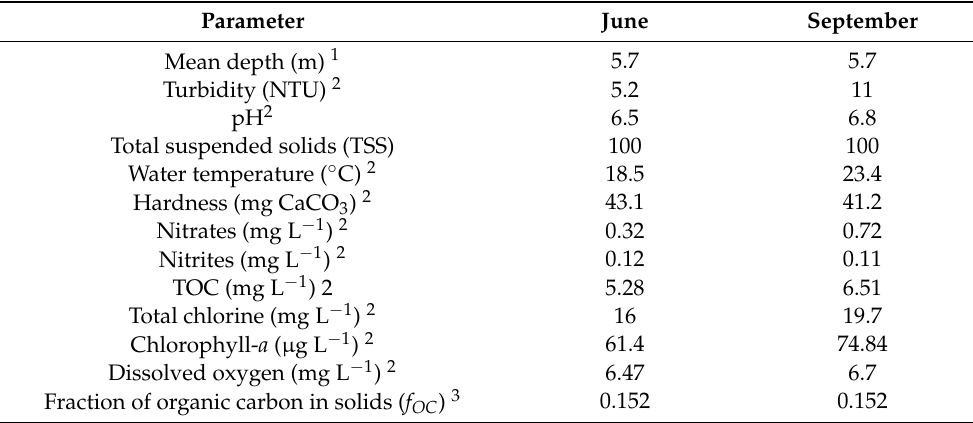
Figure 1. Location of the Guarapiranga reservoir. ( ) Sampling station from which the data used in the analysis were gathered. Table 1. Variables used in the mathematical simulation of the photochemical persistence of antidepressants (FLX and FLXSO 4 ) based on data collected from the Guarapiranga Reservoir in June and September 2021.